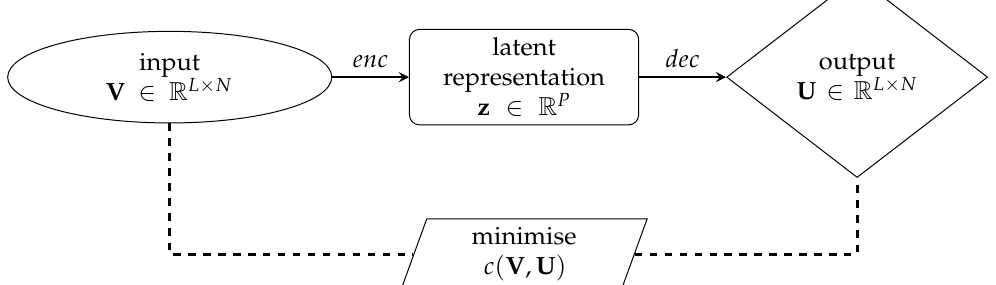
Figure 3. Schematic representation of the AutoEncoder. The loss function c ( V , U ) is computed as in Equation (1). For the enc and dec architectures, see Figures 1 and 2,